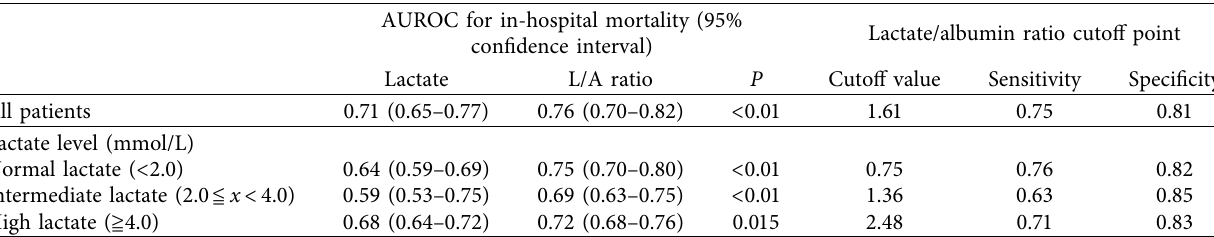
Table 2: AUROC and L/A ratio cutoff value for in-hospital